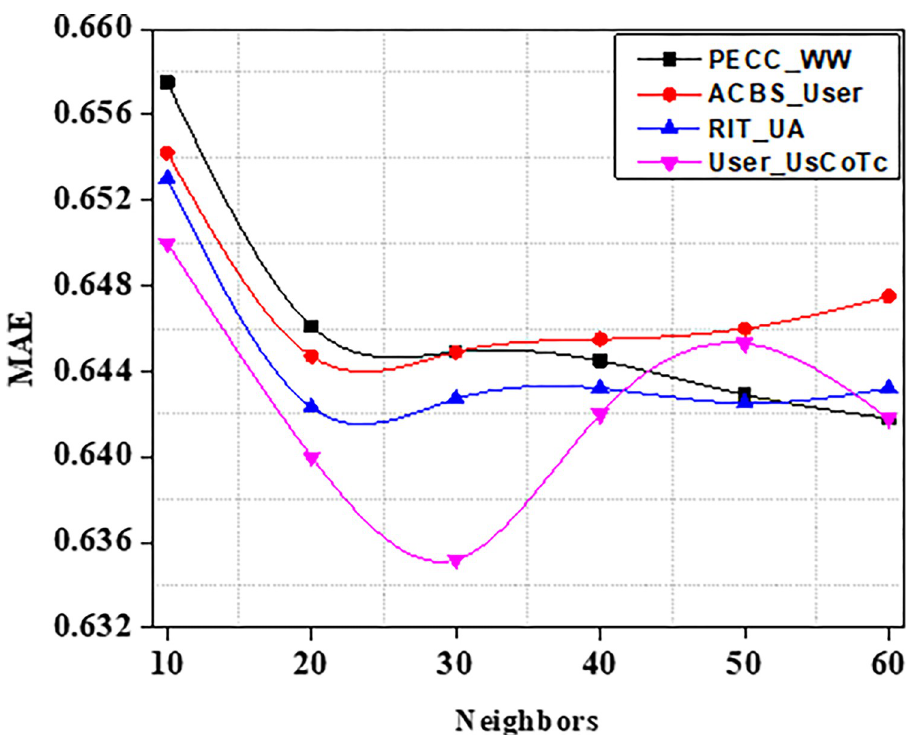
Fig 11. MAE with varied neighbors